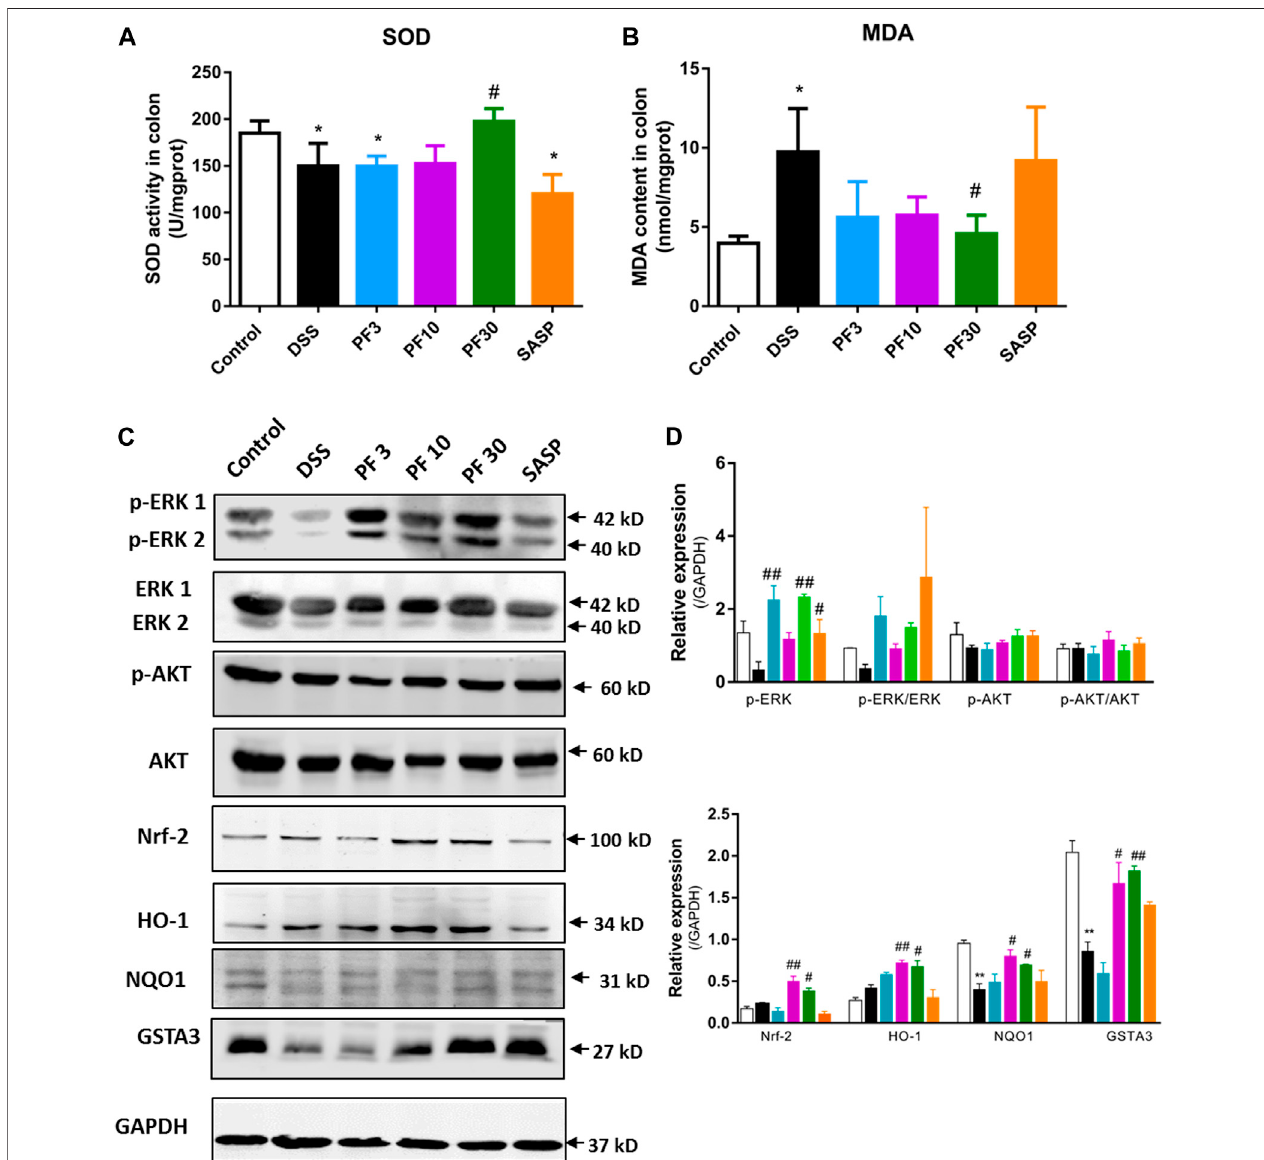
FIGURE 2 | PF-04447943 suppressed oxidative stress inducing Nrf-2 activation against DSS induced colitis mice. (A) – (B) The level of SOD and MDA were measuredincolonhomogenates. (C) Theexpressionof p -ERK,ERK,p-AKT, AKT,Nrf-2,HO-1,NQO1,andGSTA3inthecolonwasassessedbywesternblotanalysis. (D) – (E) Relativeproteinexpressionofp-ERK,p-AKT,Nrf-2,HO-1,NQO1,andGSTA3,respectively.Dataarepresentedasmean ± standarderrormean(SEM)( n (cid:1) 2 – 5). Here, *** p < 0.001, ** p < 0.01, * p < 0.05 vs. control group and ### p < 0.001, ## p < 0.01, # p < 0.05 vs. DSS-treated